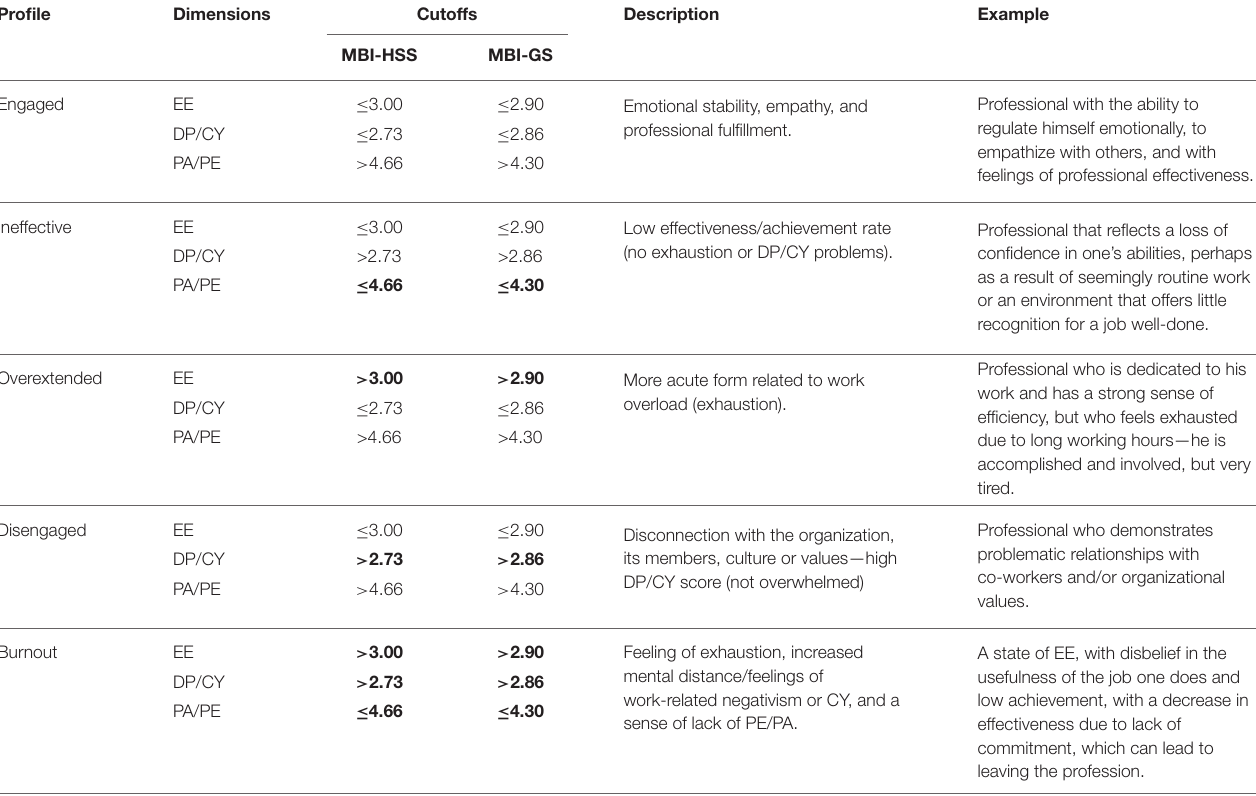
TABLE 1 | Clinical profiles and standardized critical boundaries based on the results of the burnout